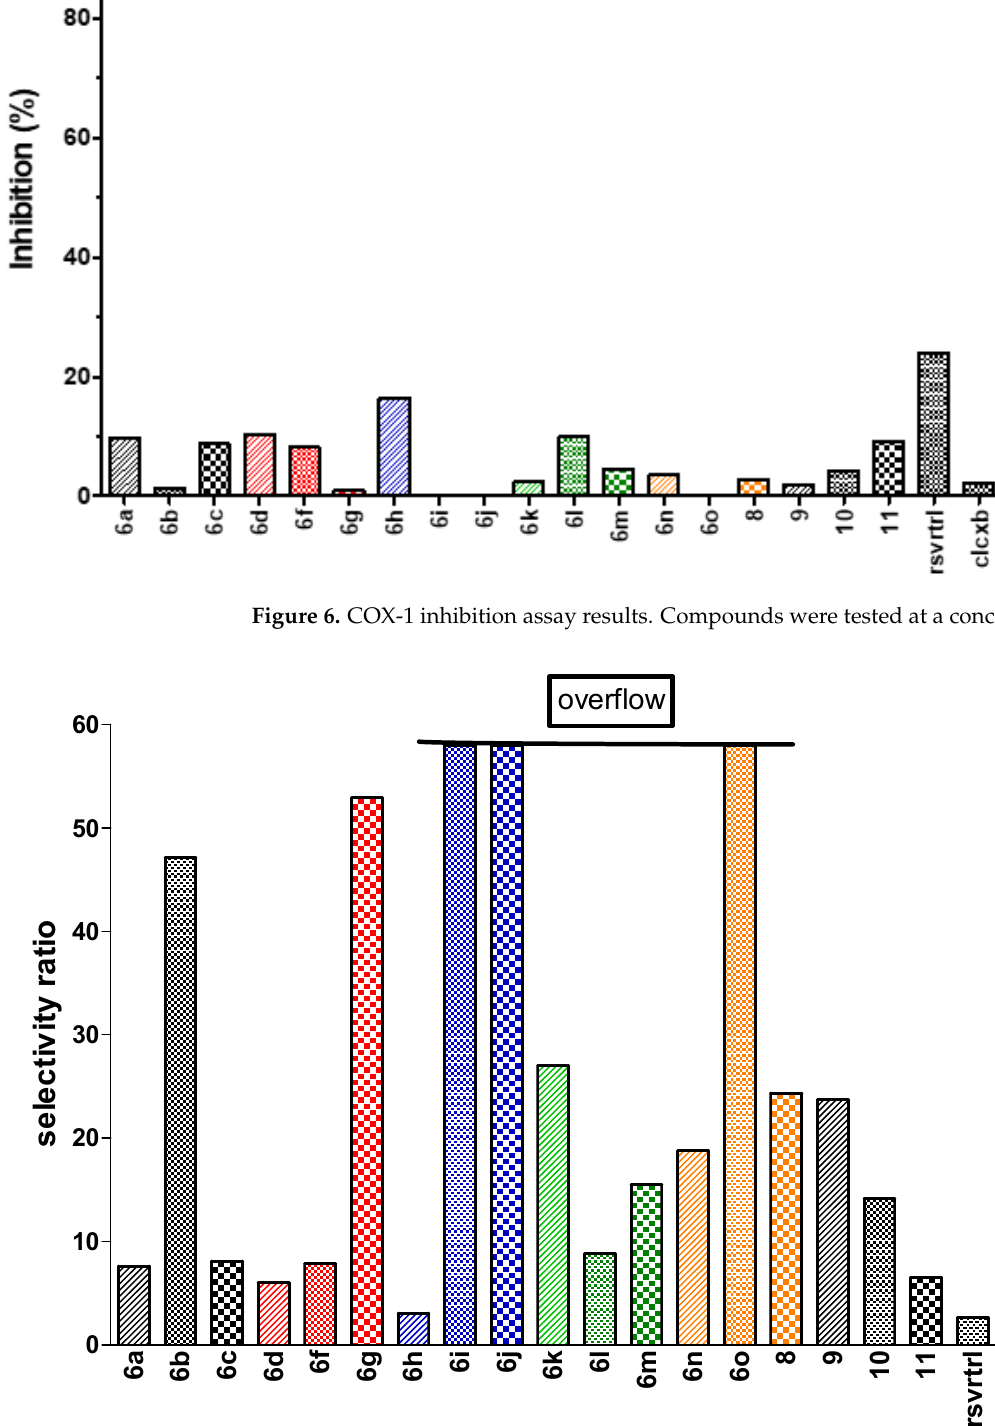
Figure 7. COX-2 vs. COX-1 inhibition ratio by compounds 6i , 6j and 6o were greater than 60 due to their near-background COX-1-inhibition values.